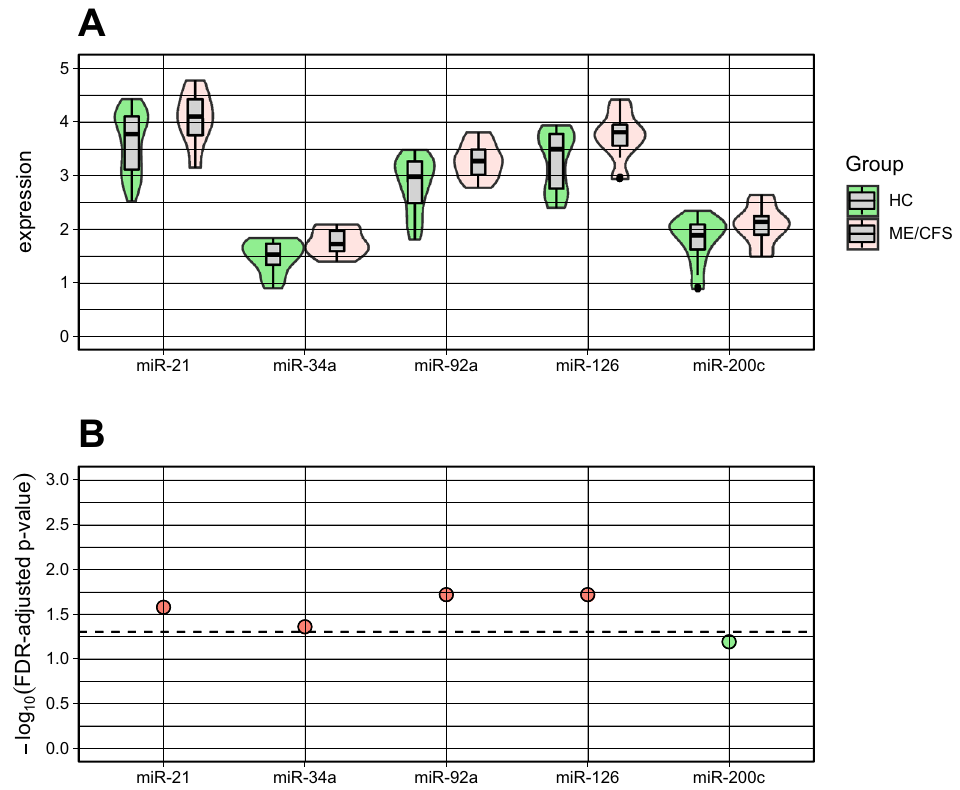
Figure 6. Analysis of publicly available microarray data derived from PBMCs. ( A ) Violin plots summarizing the expression data from each miR in PBMCs from healthy controls (HC) and patients with ME/CFS. ( B ) Association analysis adjusting for a FDR of 5% and controlling for age and gender where the dashed line represents -log 10 (0.05) and red dots represent the statistically significant associations between ME/CFS and the respective miR. Check legend of Fig. 5 for additional information about how to interpret this plot. The statistical analysis was performed in the R software version 4.0.2 (https:// www.r- proje ct.